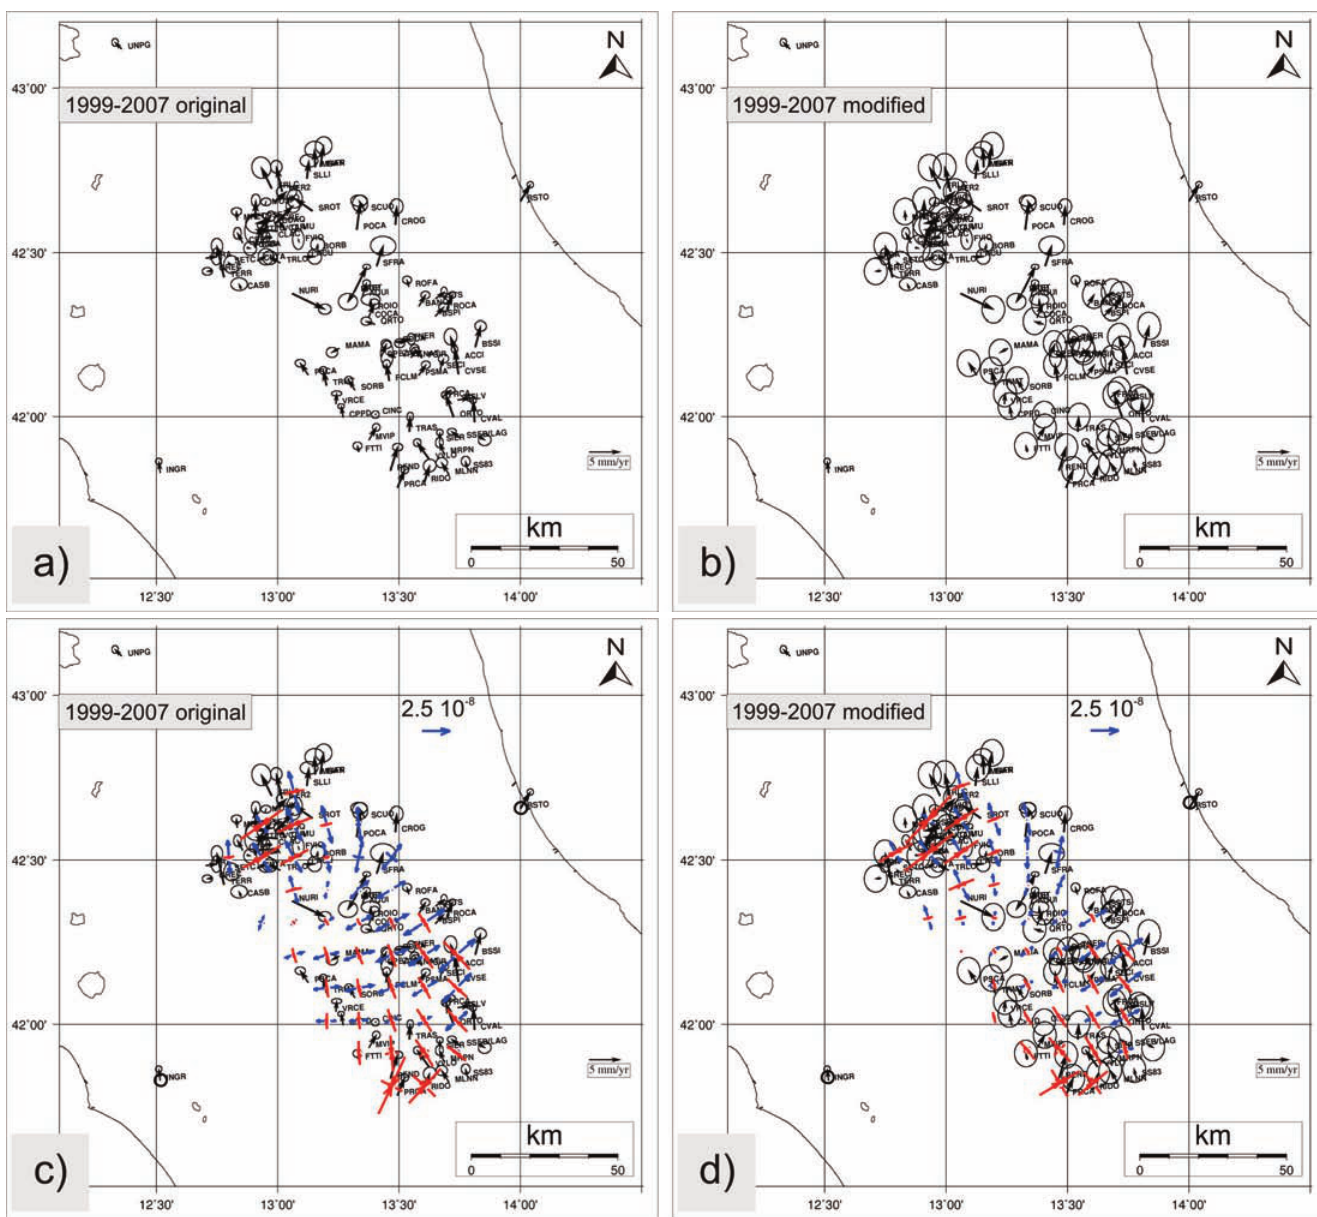
Figure 6. Velocity patterns and associated 95% confidence error ellipses obtained with standard (a) and threshold-modified (b) uncertainties. Strain-rate fields were computed using the same velocity patterns, but different associated errors, as standard (c) and threshold-modified